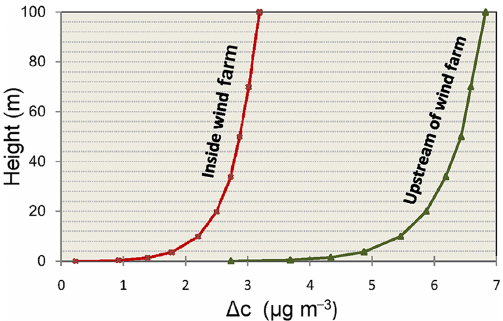
Figure 15. Vertical profile of concentration gradient in the neu- tral boundary layer. The wind speed at the hub height was set as 4ms − 1 , the surface roughness length was set as 0.01m, and hub height as 60m. Concentrations were taken as 100µgm − 3 at the 1.5m height and 80µgm − 3 at the 10m